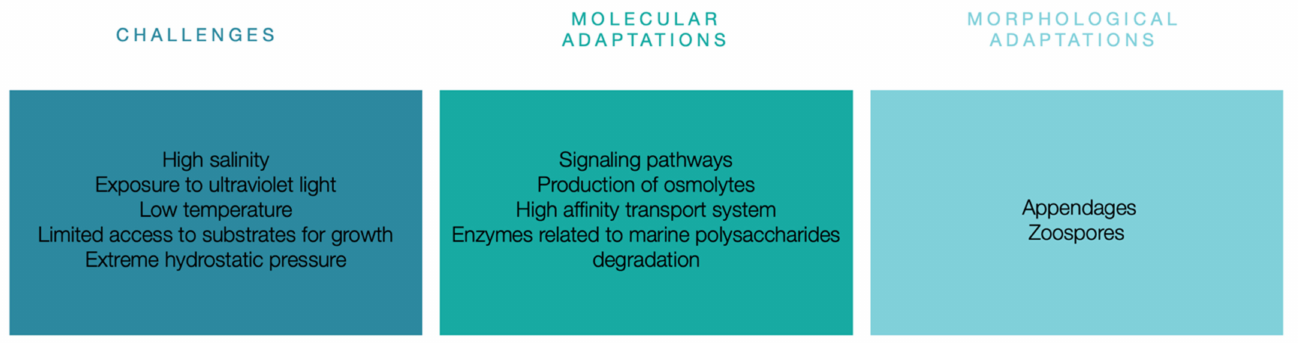
Figure 2. Challenges and adaptations of marine fungi to the marine